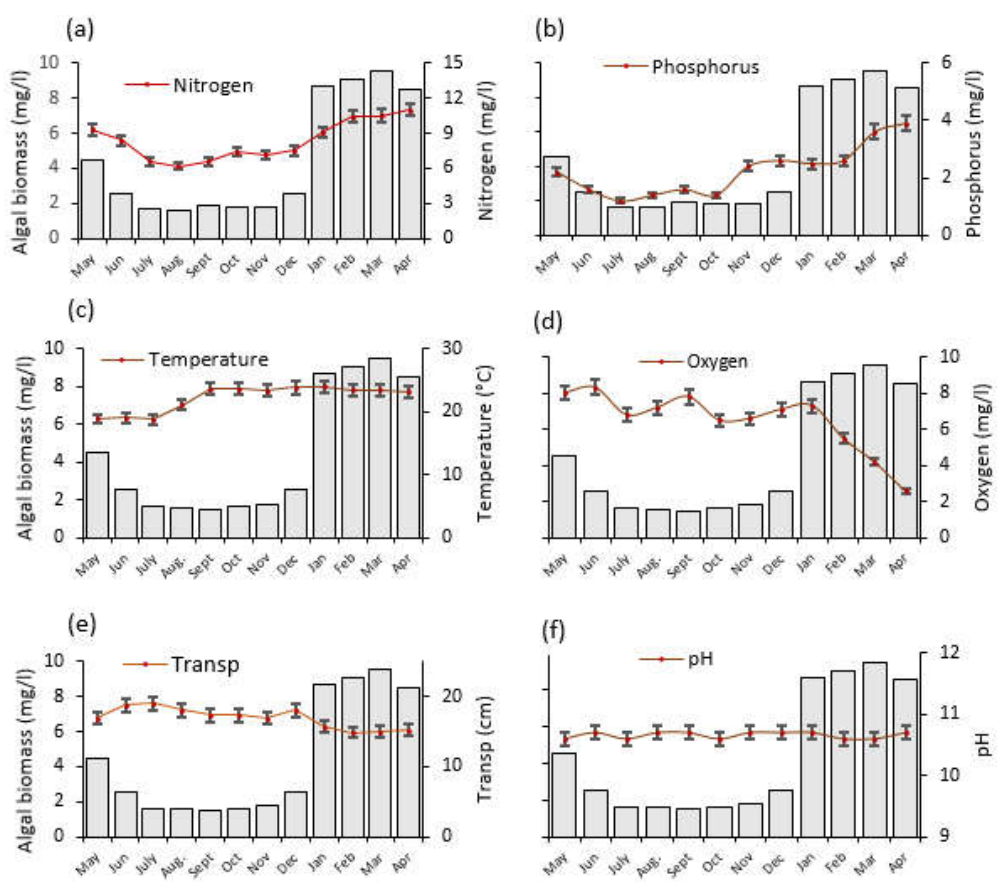
Figure 4. The temporal trends of average (±SE) physico–chemical water quality parameters and algal biomass as monitored from May 2020 to April 2021 at Lake Big Momella, northern Tanzania; ( a ) Nitrogen, ( b ) Phosphorus, ( c ) Temperature, ( d ) Oxygen = dissolved oxygen ( e ) Transp = water transparency and ( f ) pH. Please note that the left y-axis denotes algal biomass (mg/l), indicated by gray bars, for all panels.